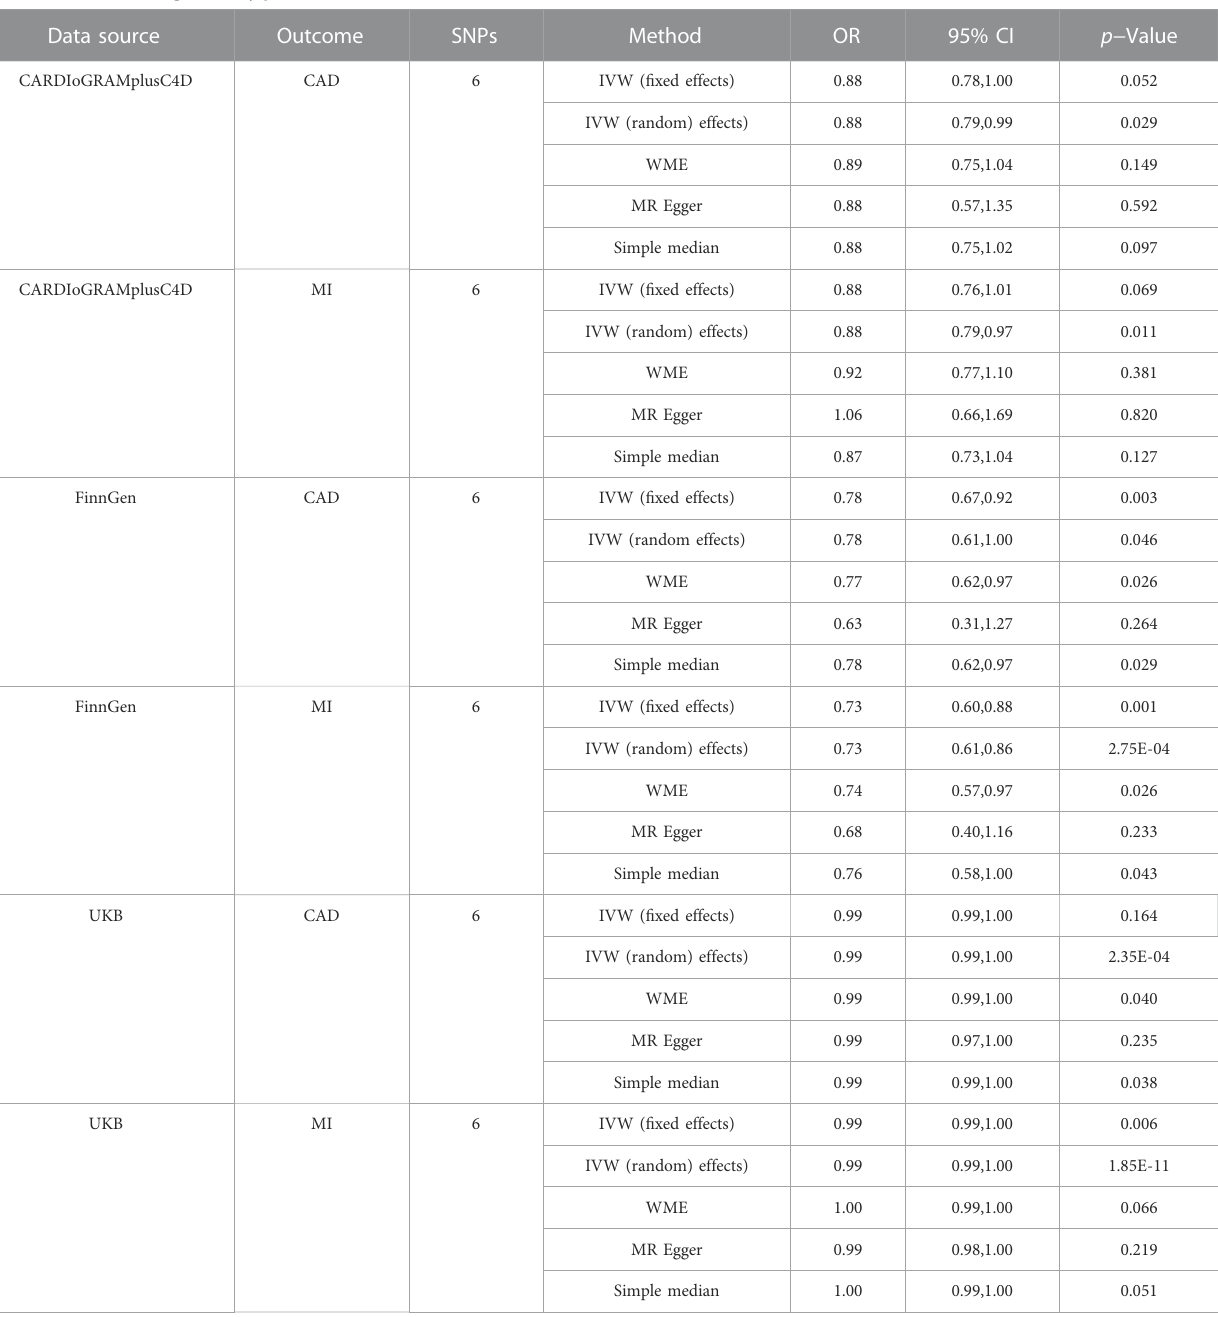
TABLE 2 Associations of genetically predicted RuminococcusUCG010 with CAD and